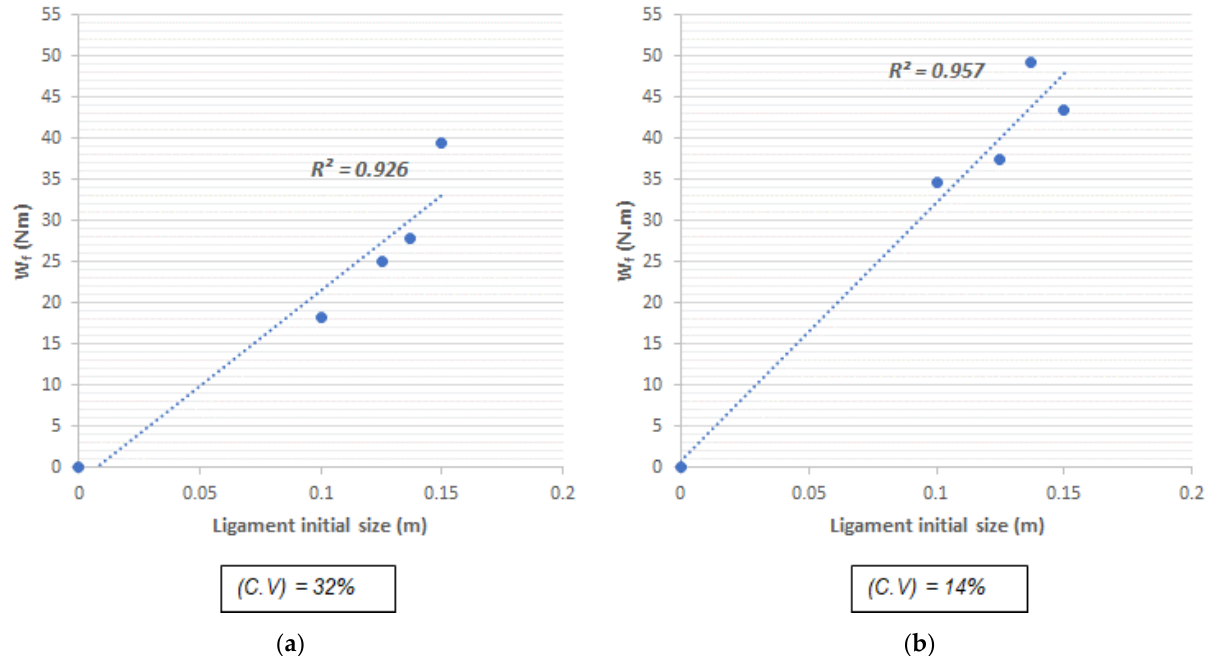
Figure 11. Curve fit for the computation of the fracture energy by the slope fracture work model 2: ( a ) Series 1 and ( b ) Series 2.